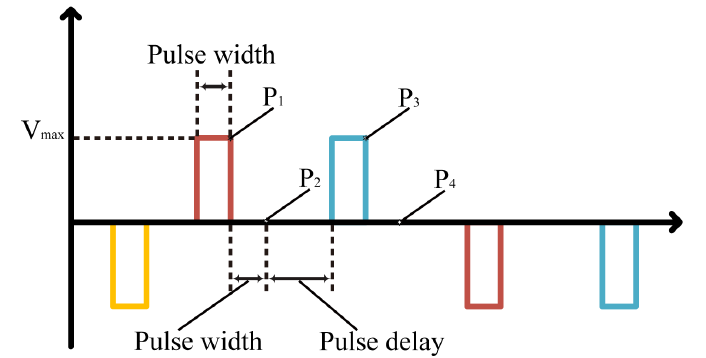
Figure 2. ( a ) Schematic diagram of magnetron sputtering deposition of Al 0.7 Sc 0.3 N . ( b ) Stacking schematic of Pt/Mo-AlScN-Al structure.